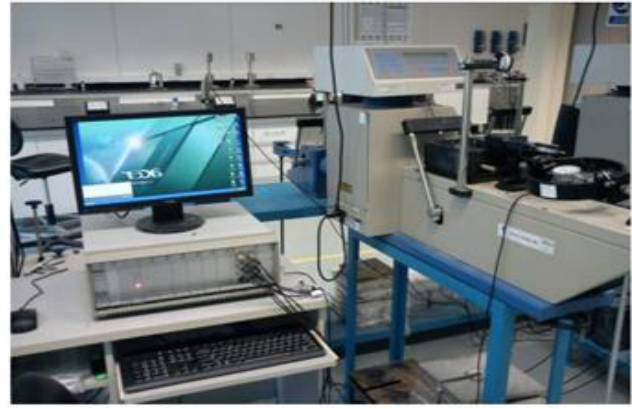
Fig. 2. Experimental arrangement for ER